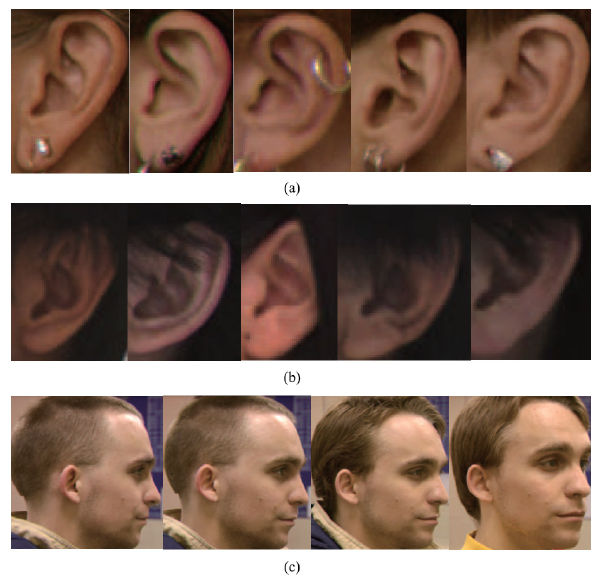
Figure 10. Examples of correct recognition in the presence of occlusions and pose variations. ( a ) occlusions with earrings; ( b ) occlusions with hair; ( c ) four kinds of pose variations.